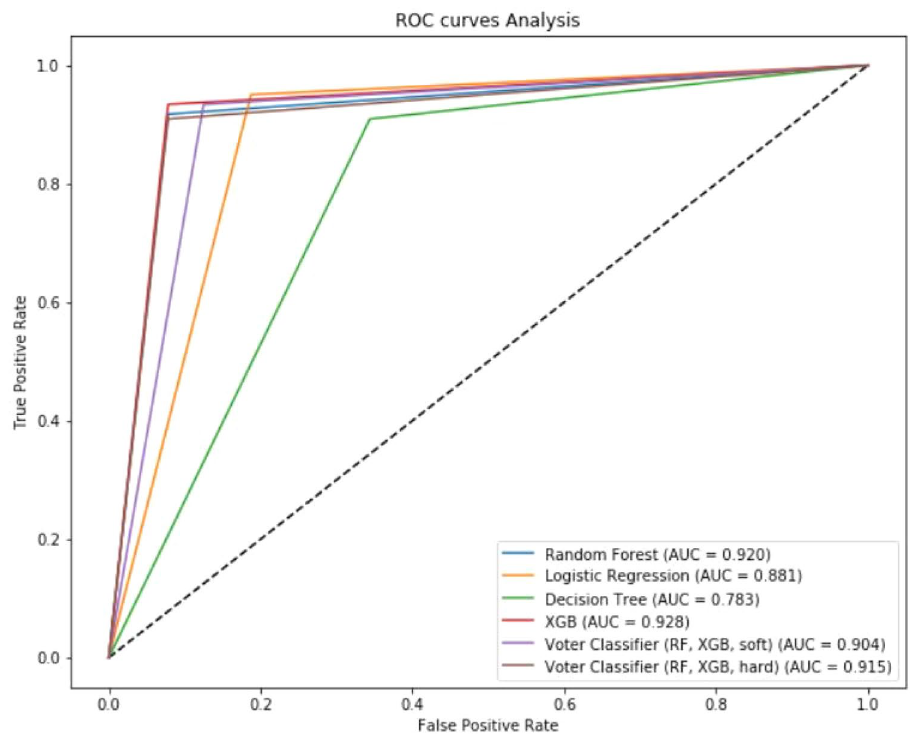
Figure 4. ROC curve analysis of models in training set.